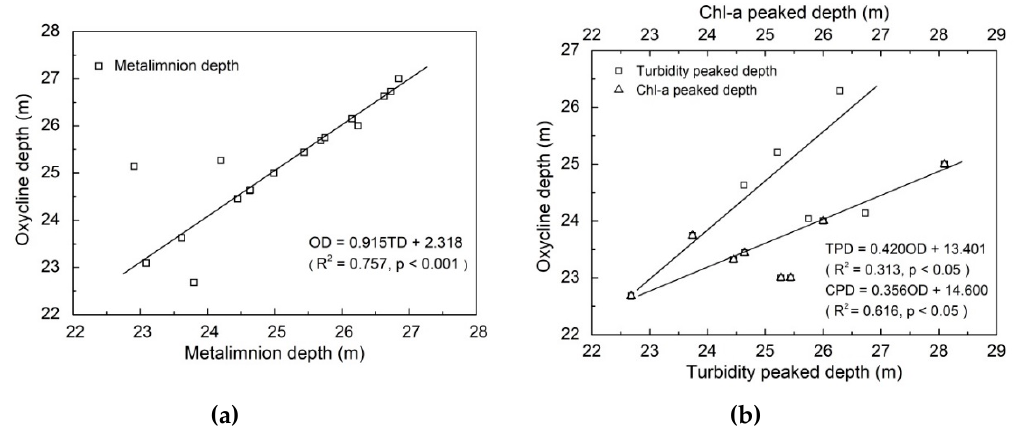
Figure 4. Seasonal water temperature depth profile of S1 site ( a ), thermal stratification index RWCS/H ( b ) in Lijiahe Reservoir in 2017.